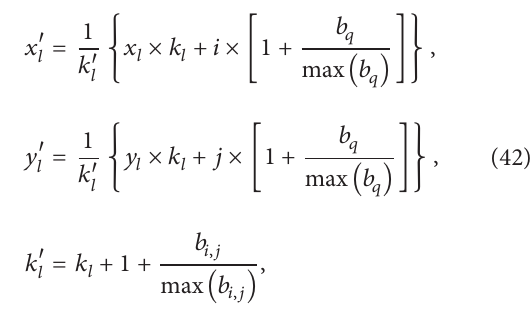
Figure 4: Geometric relationship among the antenna, target, and ghost in monostatic mode. 𝑀 𝑁 𝐵 and 𝐵 are the number of pixels in range axis and cross range axis,